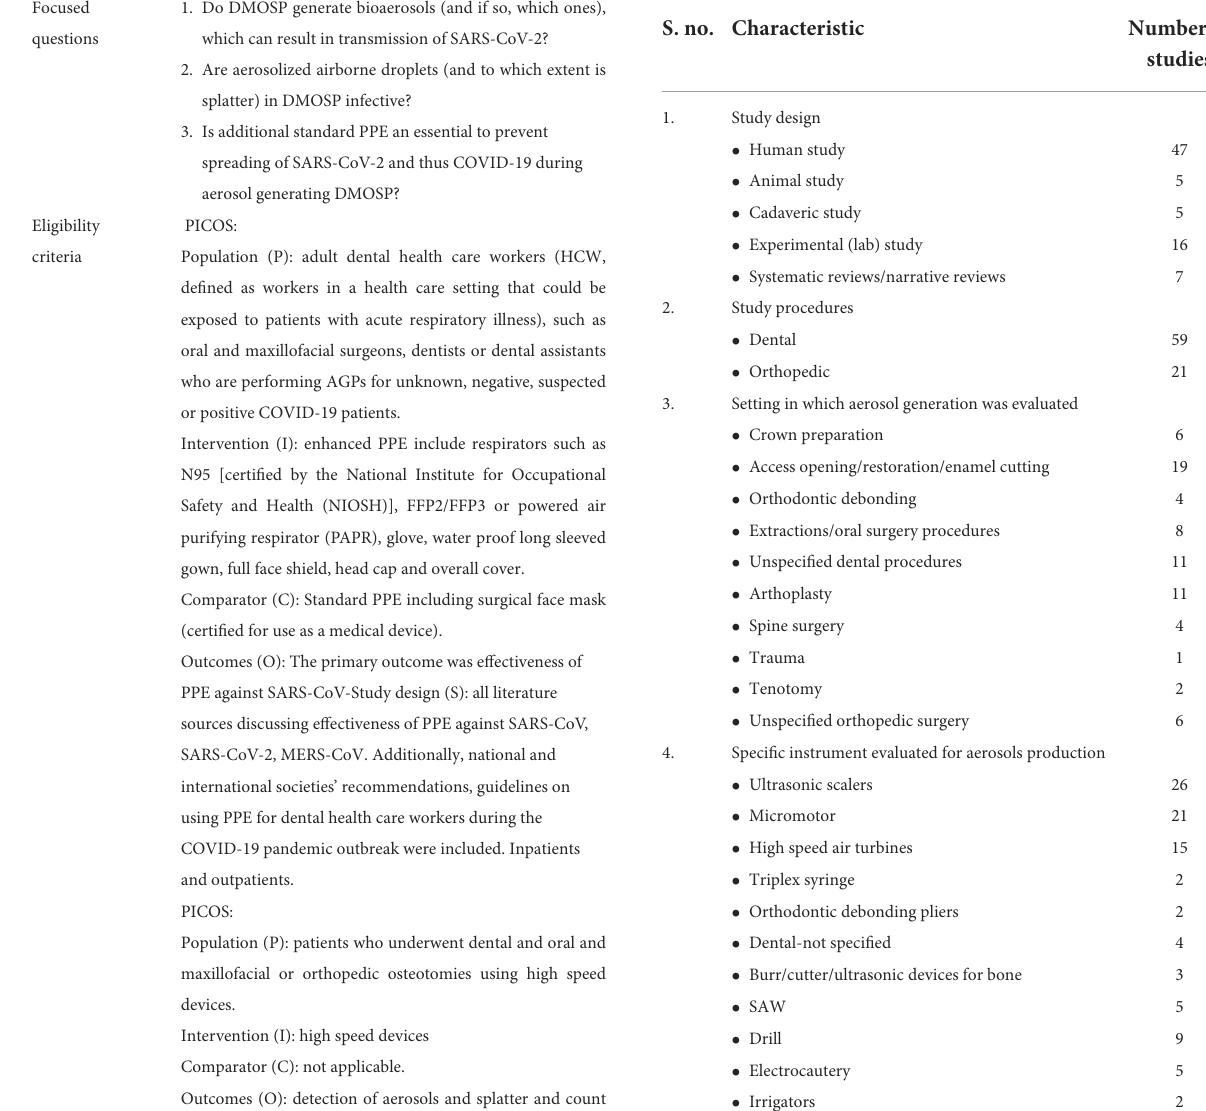
TABLE 1 Focussed questions of the study and eligibility criteria. TABLE 2 Characteristics of studies included in the systematic review